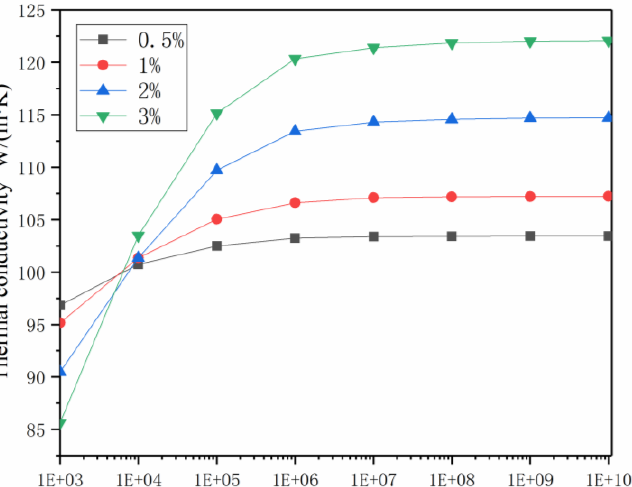
Figure 5. The k c values of CNTs/Co models with randomly distributed CNTs as a function of the C C- Co at CNT loadings of 0.5% vol., 1% vol., 2% vol., 3% vol.